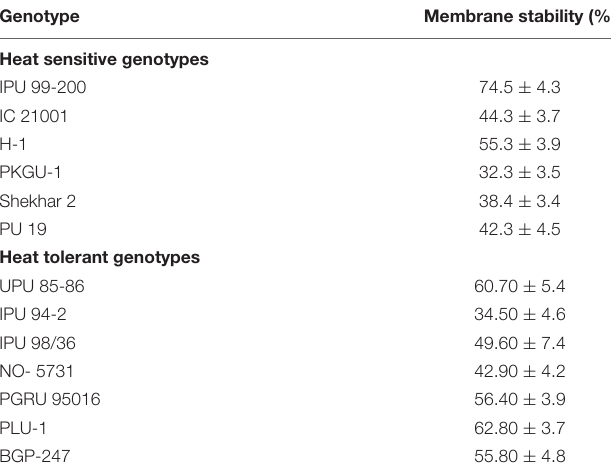
TABLE 7 | Membrane stability of 13 urdbean genotypes. TABLE 8 | Correlation analysis of nitrogen balance index (NBI), chlorophyll, flavanol, anthocyanin contents, and membrane stability.